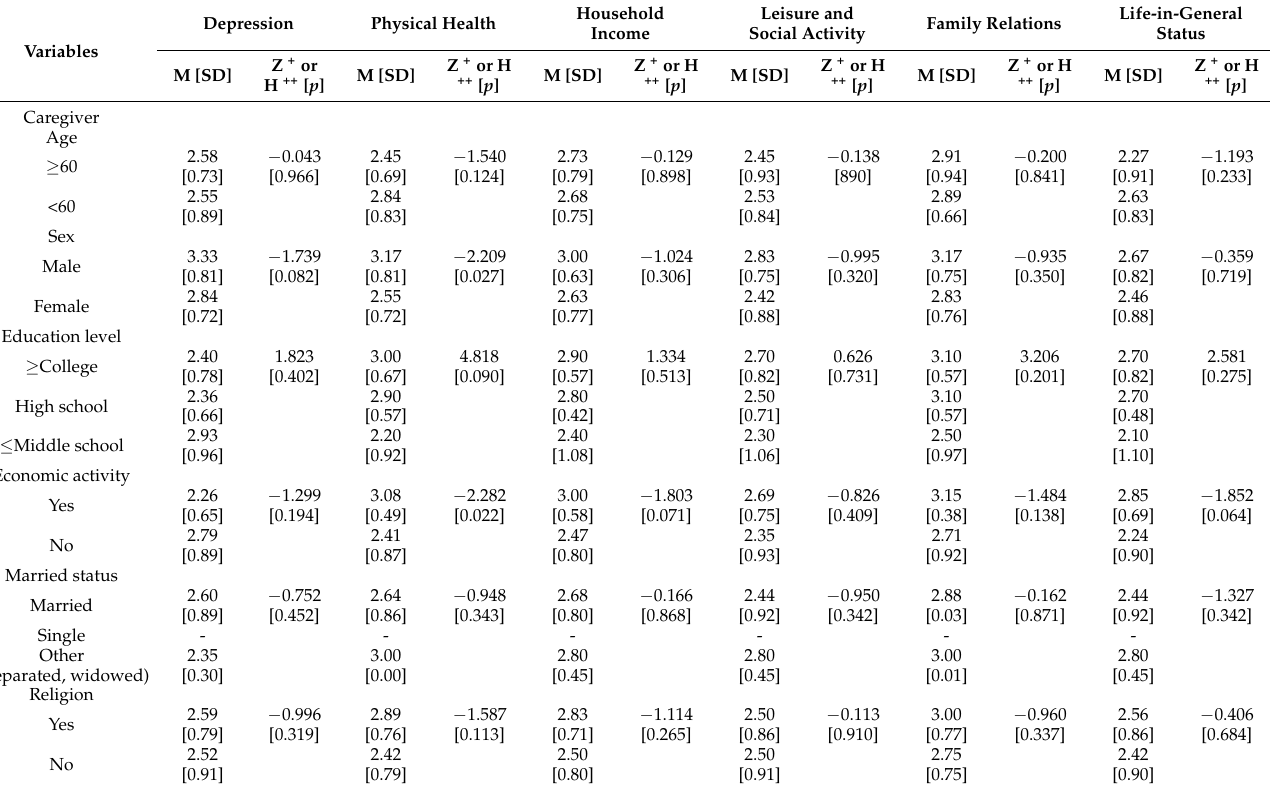
Table 3. Comparison of caregiver’s depression, physical health, household income, leisure and social activity, family relations, and life-in-general status from the general characteristics (caregiver and